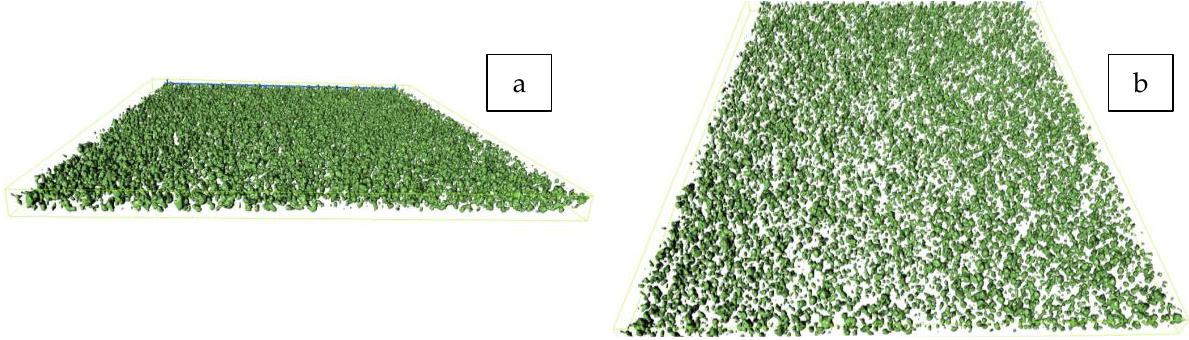
mean height of the surface) for the analyzed area are shown in Figure